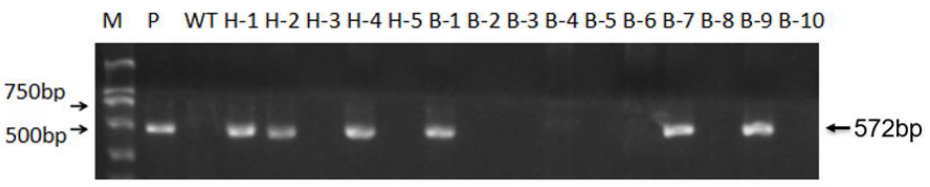
8 of 16 Figure 4. Sequencing results of main T 0 transgenic plants. WT: wild type(Y58S); W-1&W-4&W-6: mutant plants. Table 3. Main mutation types of Wx gene target in Y58S T 0 transformation material of rice. WT: wild type; W-1 and W-4 and W-6: mutant type. Transformation Material